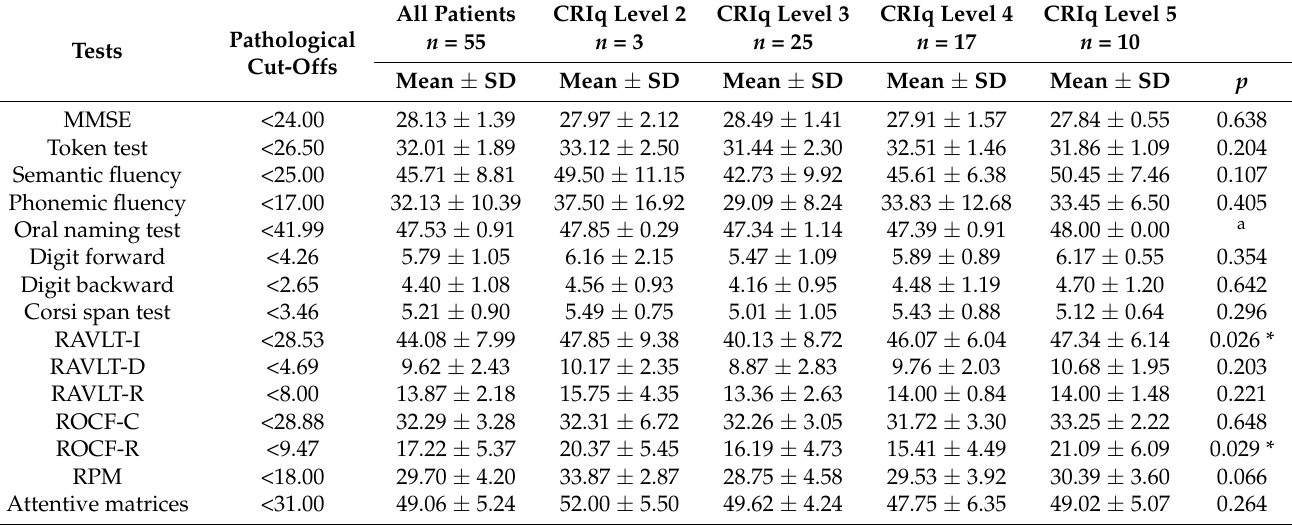
Table 4. Univariate ANOVA between groups identified according to CRIq level on single neuropsy- chological tests (controlling for disease